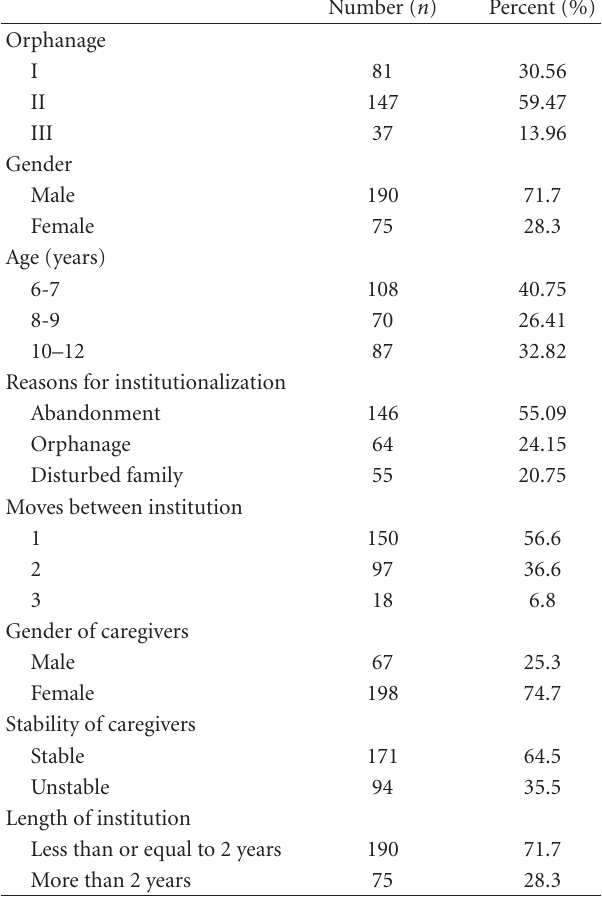
Table 1: Sociodemographic characteristics of the studied